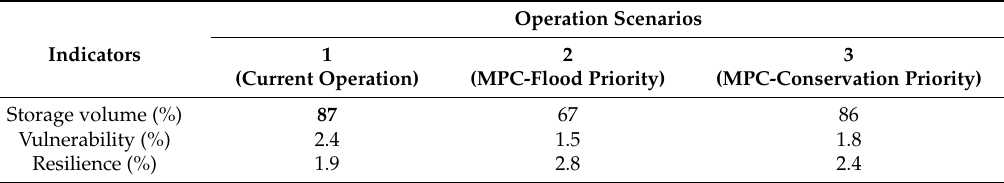
Table 2. Overall performance of the three operation scenarios.